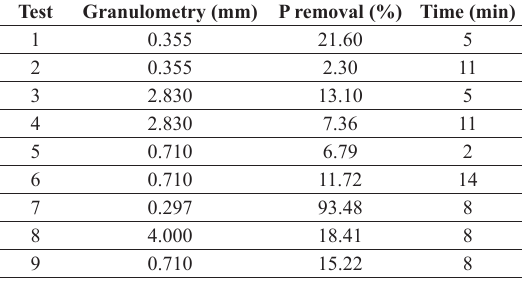
Table 3. Levels used in factorial planning